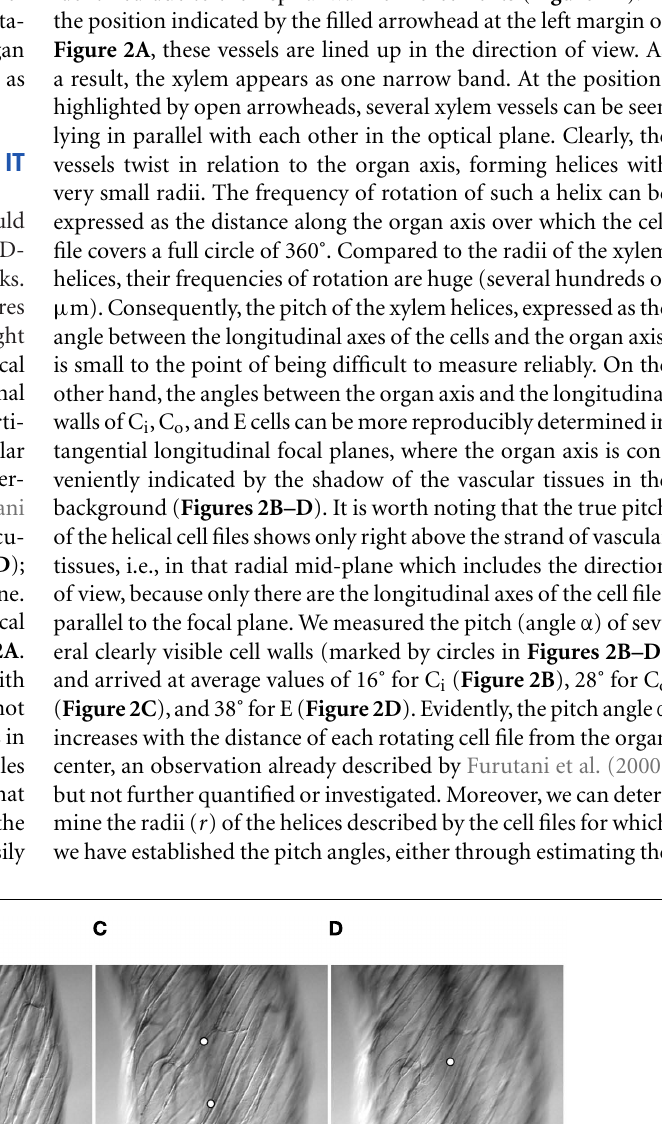
FIGURE 2 | Light micrographs of an etiolated Arabidopsis spr1 mutant hypocotyl, taken with the focal plane in the organ mid-plane (A), the inner cortex (B), the outer cortex (C), and the epidermis (D). Identity of tissue layers are indicated on top of (A) (V, vascular system; N, endodermis; C i , inner cortex; C o , outer cortex; E, epidermis).The approximate positions of the focal planes of (B–D) relative to the various cell layers is marked at the bottom of subfigure (A) . Closed and open arrowheads on the left of (A) highlight regions in which xylem strands are either lined up in the direction of